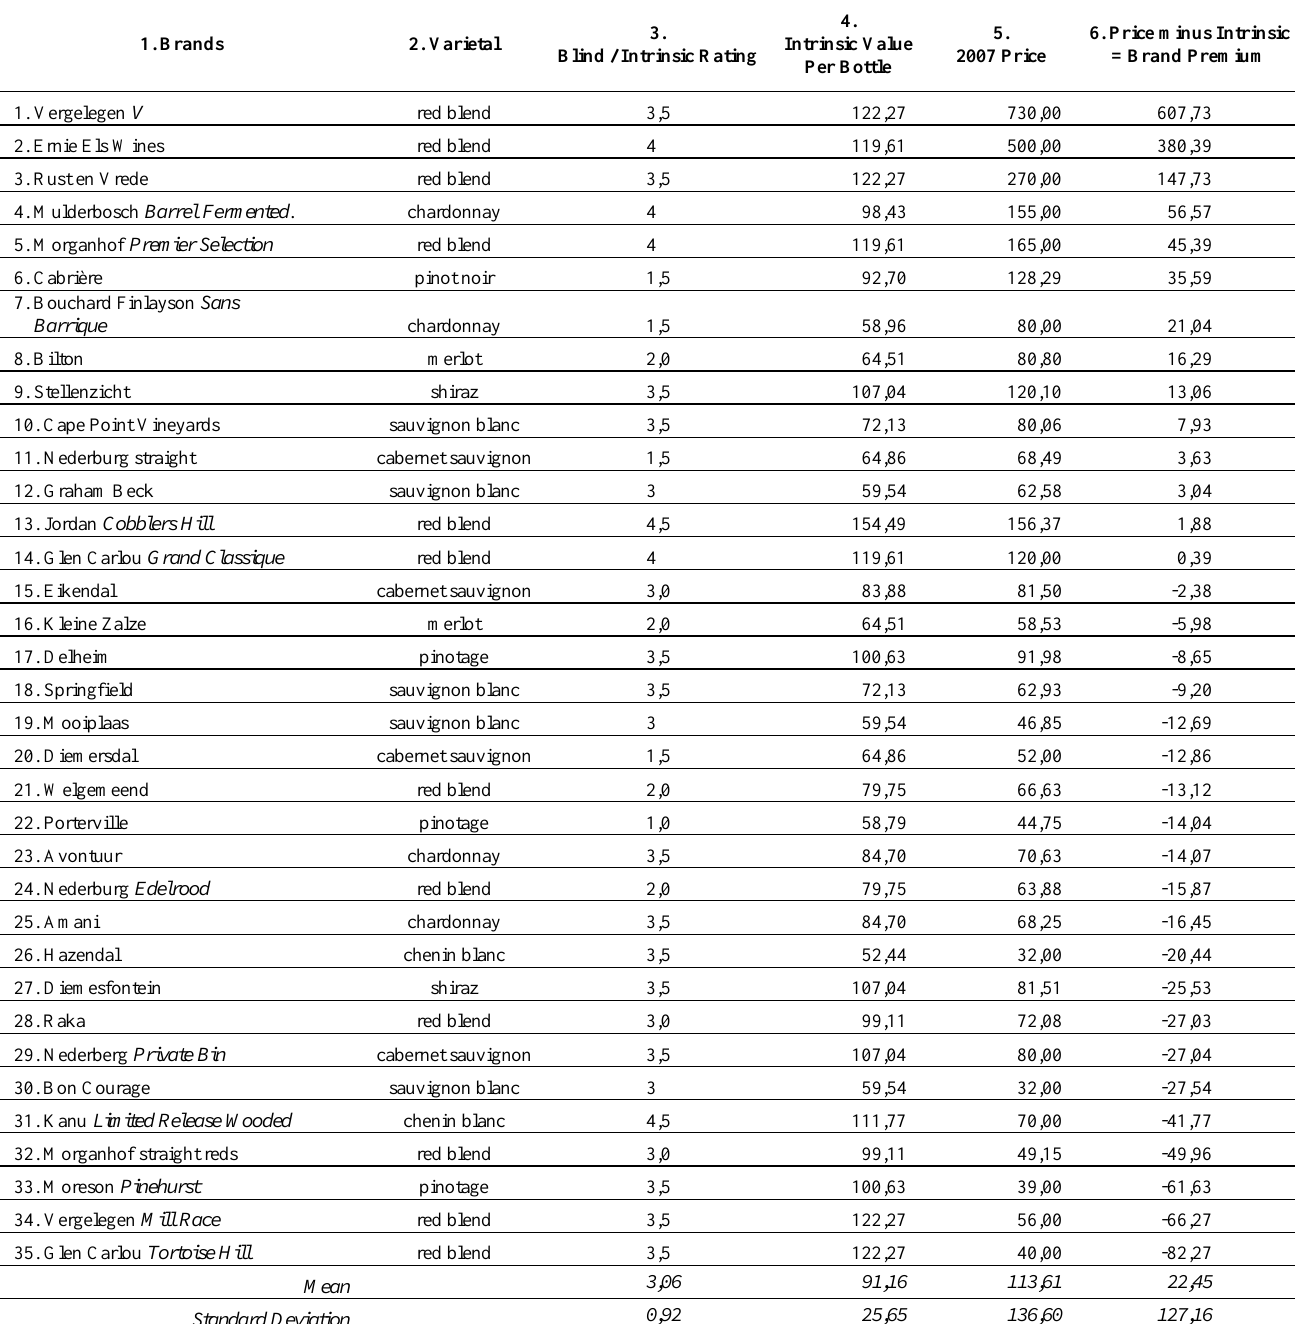
Table 4: Brand premium valuation per bottle as measured by the Price-Premium method. This is the difference between p rice (2007) and intrinsic quality valuations (in Rands). We calculate these intrinsic/ “no-name brand” valuations per bottle using the appropriate intrinsic values (in col.3), as per the pricing models presented in Table 3. These valuations appear thus in column 4 above. Column 6 presents the brand premium valuation by calculating the difference between columns 5 and 4, and the table is ranked by descending order of this